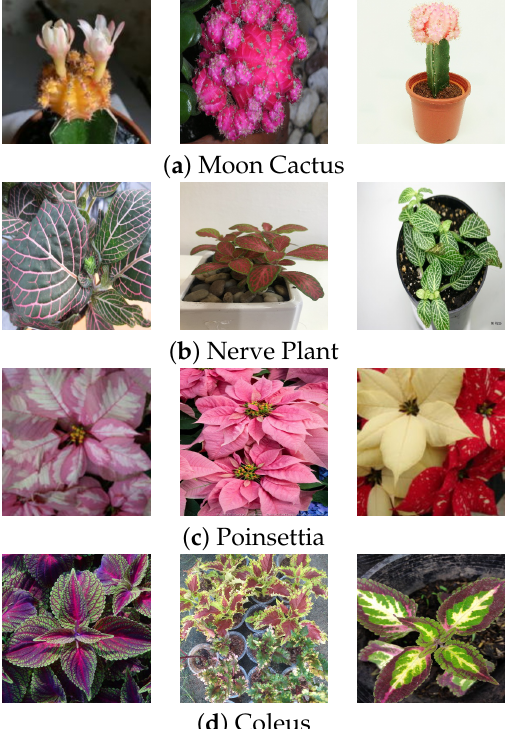
Figure 2. Classes that cannot be distinguished on color alone (moon cactus, nerve plant, poinsettia) or shape alone (coleus).